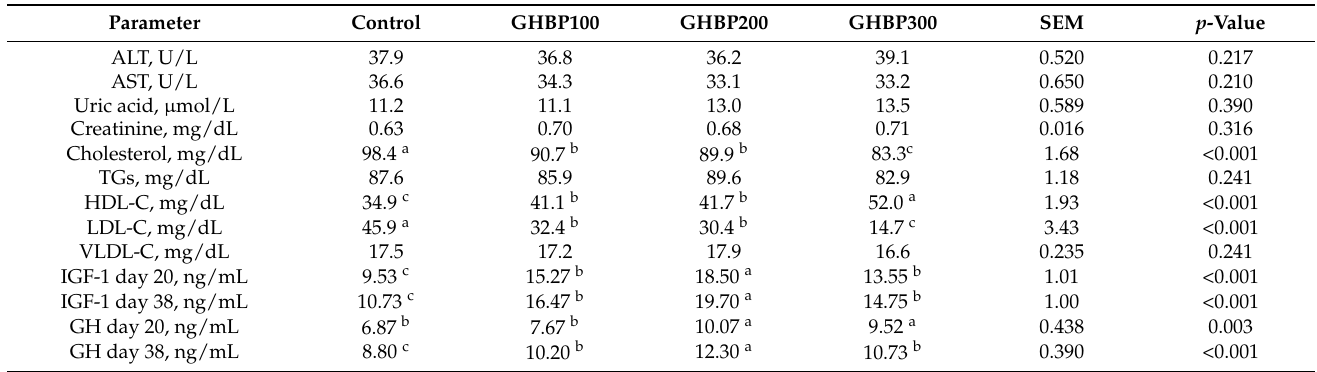
Table 5. Effect of dietary GHBP on serum biochemical parameters of broiler chickens.